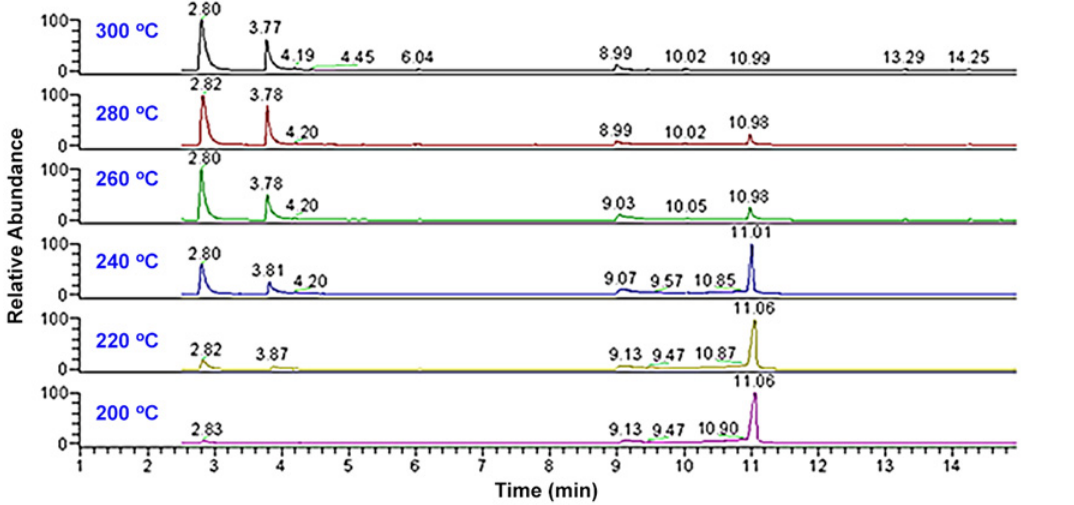
Fig 4. A series of TIC of trichlorfon with different GC injector